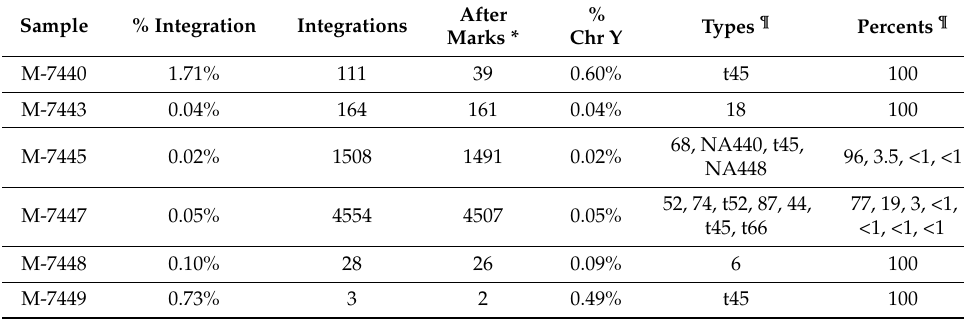
Figure 3. Examples of HPVint. ( A ) Two integrations at different known cancer genes ( RAD51B and MACROD2 ). ( B ) Two detected integrations at the same position of the RAB32 gene of reads showing different lengths. Note the region rich in GT. Arrows denote marked reads within detected tandem repeats regions. Nucleotides in lowercase denote mismatches relative to the target sequence; if underlined, refer to insertion relative to the target. The vertical axis at the left refers to integrations, whereas the right axis refers to overall HPV mapping. Table 3. Detected integrations per sample and HPV